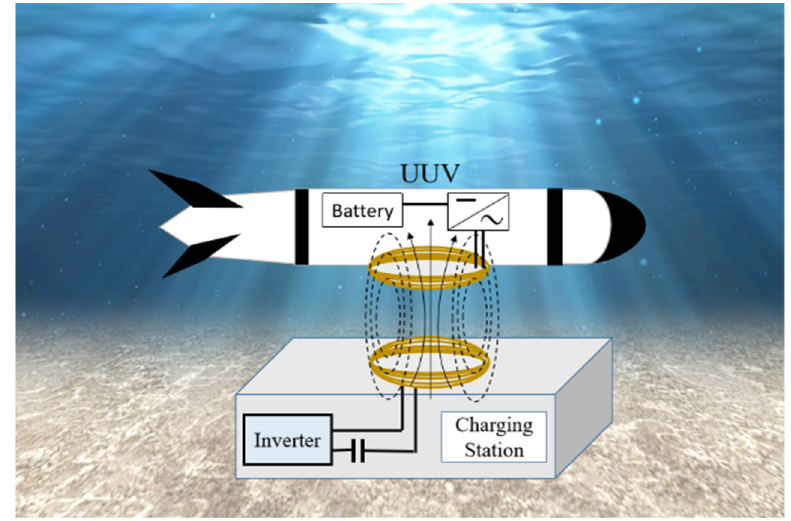
Figure 2. Overview of UWPT system to charge UUV.